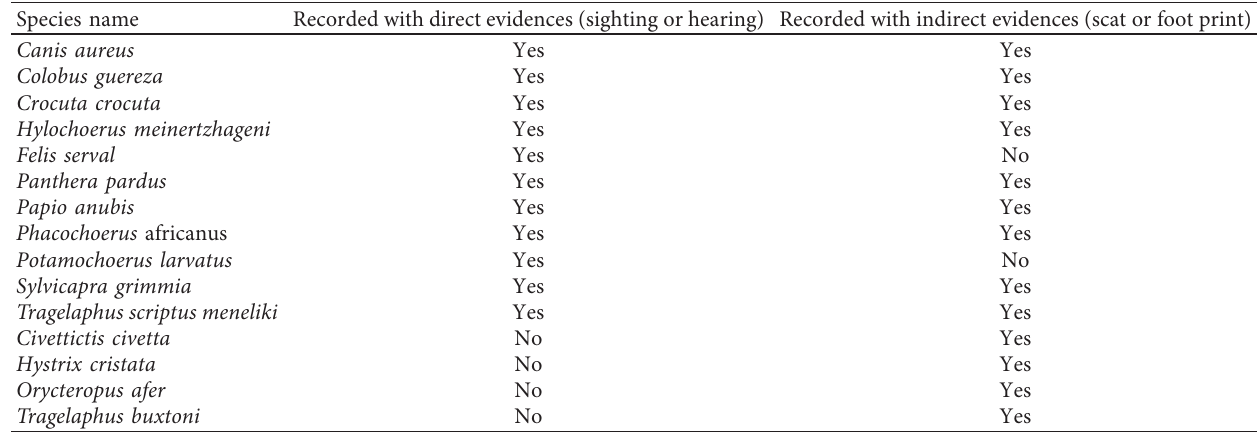
Table 2: Large mammal species reordered with direct evidences and indirect evidences from Nensebo forest, Southern Ethiopia. Species